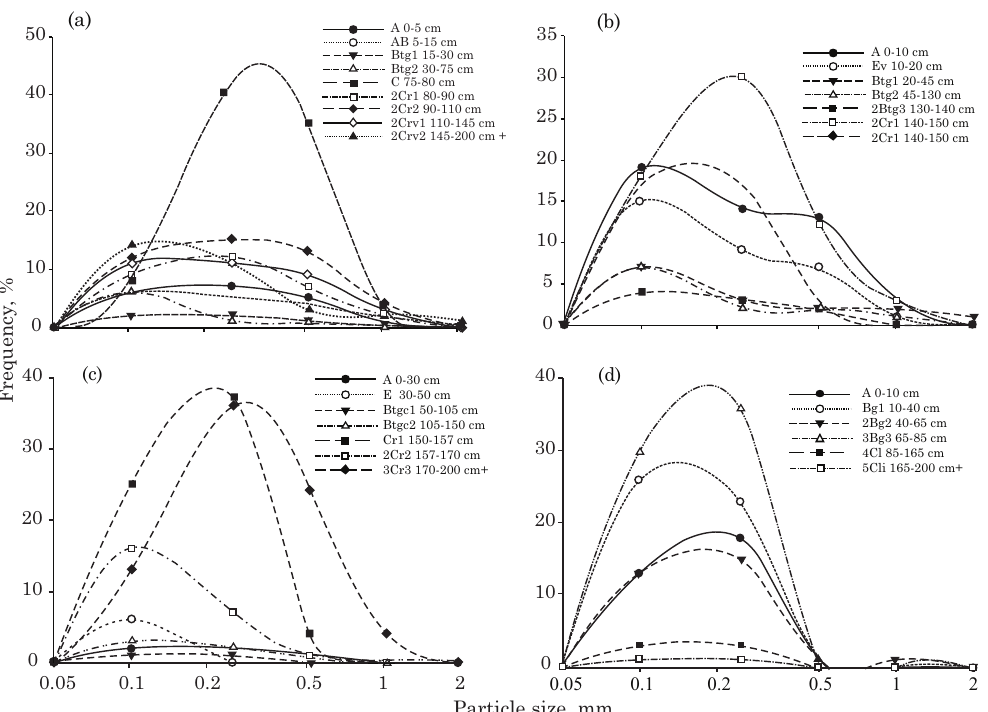
Figure 3. Sand fraction distribution (0.05-0.1 mm - very fine; 0.1-0.25 mm - fine; 0.25-0.5 mm - medium; 0.5-1 mm - coarse; 1-2 mm - very coarse) of AP1(a), AP4 (b), AP10 (c) and AP11